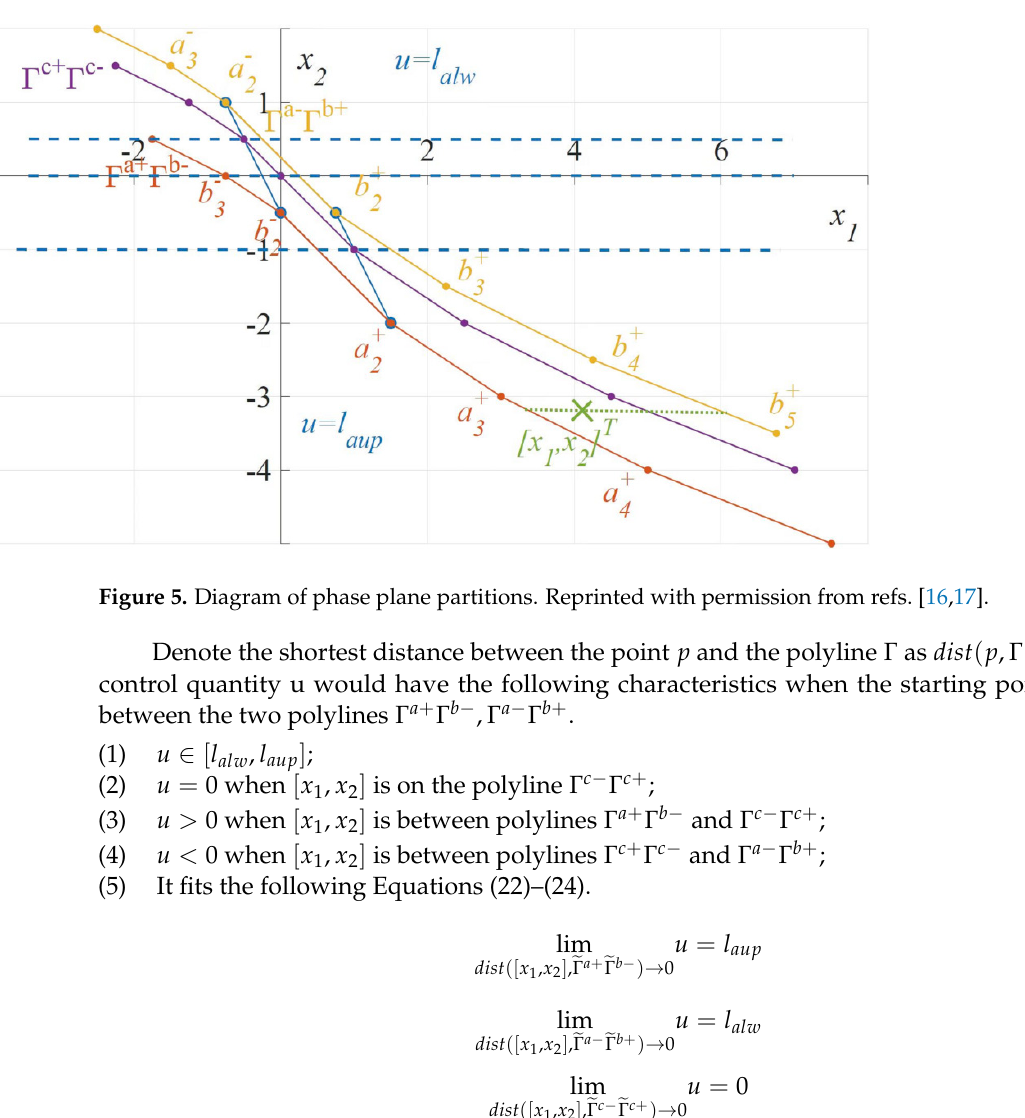
If the state point is located in the region that is formed by (cid:101) Γ a + (cid:101) Γ b − and (cid:101) Γ a − (cid:101) Γ b + (as shown in Figure 4), the control quantity u can be calculated through interpolation according to the transverse distance between the state point and (cid:101) Γ c − (cid:101) Γ c + . Then, the value of u can be calculated as shown below, where (cid:101) x 1 ( (cid:101) Γ , x 2 ) stands for the value of the abscissa x 1 that is at the corresponding ordinate x 2 on the curve (cid:101) Γ .